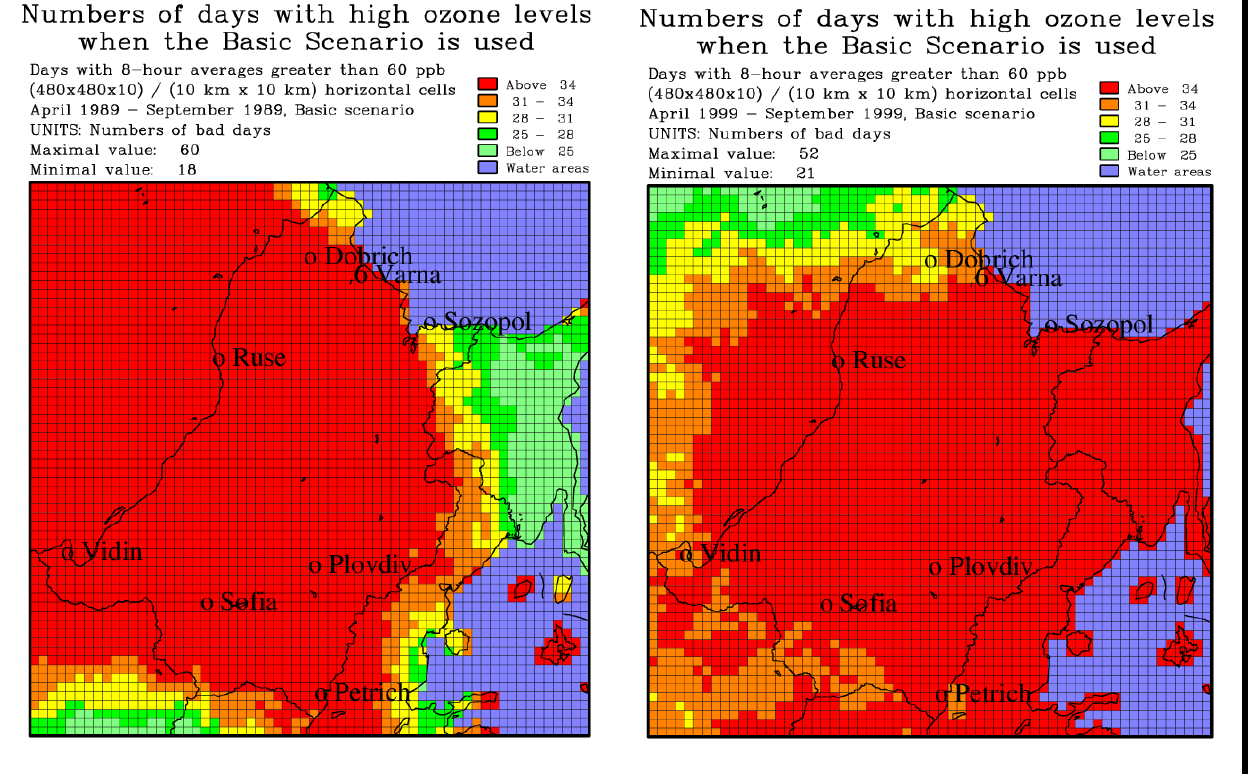
Figure 8. Results obtained in the subdomain of UNI-DEM containing Bulgaria. The grid-lines as well as colours presenting information about the numbers of “bad days” in year 1989 (the left-hand-side plot) and in year 1999 (the right-hand-side plot) are given in these two plots. It is seen that the numbers of “bad-days” in Bulgaria during these two years was higher than 34 (the red regions), i.e., higher than the limit of 25 “bad days”, in nearly the whole country. The names of the Bulgarian towns, which will be used in the next two figures, are also given in these two plots. It is seen that these towns are located in different parts of the country.